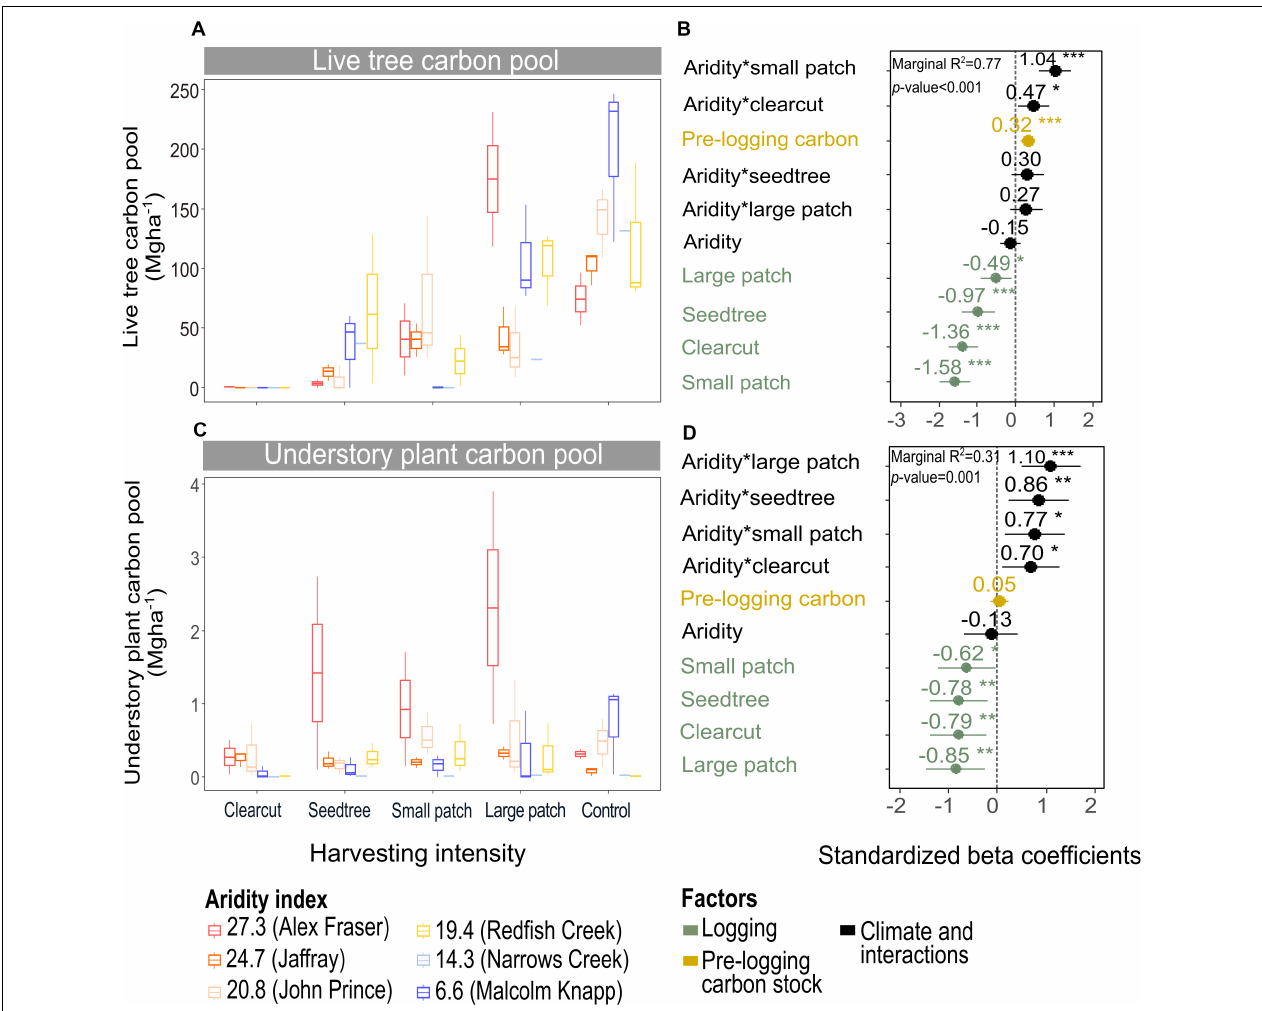
FIGURE 4 | Effect of harvesting intensity and climatic aridity on live tree carbon (A,B) and understory plant carbon pools (C,D) of mixed Douglas-fir forests ( n = 3 for all locations, except Narrows Creek where n = 1 and Alex Fraser where n = 2). (B,D) present standardized beta coefficients of linear mixed-effects models. Beta coefficients illustrate the effect of factors on the live tree carbon pool (B) and on the understory plant carbon pool (D) in terms of their standardized effect sizes. Circles indicate average estimates and lines indicate 95% confidence intervals. The aridity index was calculated as [mean annual temperature + 10]/[mean annual precipitation/1000]. For harvesting intensity, each coefficient represents the difference between the uncut control and a given treatment. *** P -value < 0.001; ** P -value < 0.01; * P -value < 0.05.